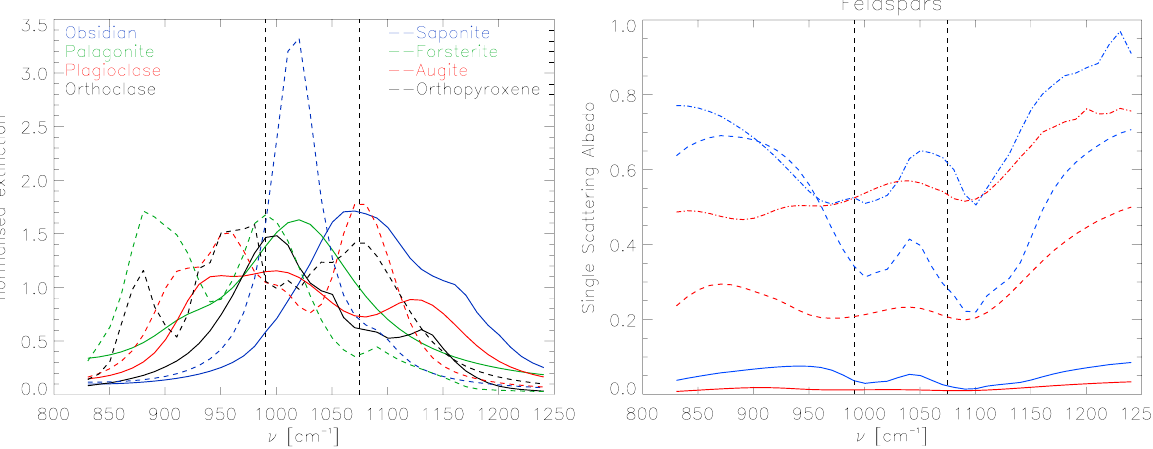
Fig. 1. Left: Extinction spectra of volcanic minerals in wavenumber ( ν) space. The vertical dashed black lines delimit the ozone absorption band not used by the retrieval (see Kl ¨ user et al., 2011). Right: Single scattering albedo of the feldspars (plagioclase in red and orthoclase in blue) for three different size distributions inspired from OPAC dust modes (solid: nucleation mode, dashed: accumulation mode, dash-dot: coarse mode).